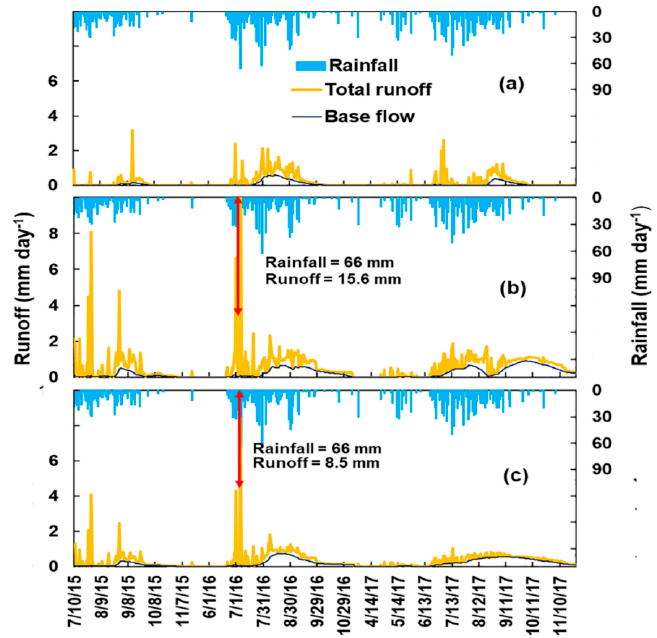
Figure 8. Baseflow and surface runoff volume in comparison with rainfall for ( a ) forested watershed at weir-2, ( b ) agricultural downstream area, and ( c ) entire Gomit watershed at weir-1.